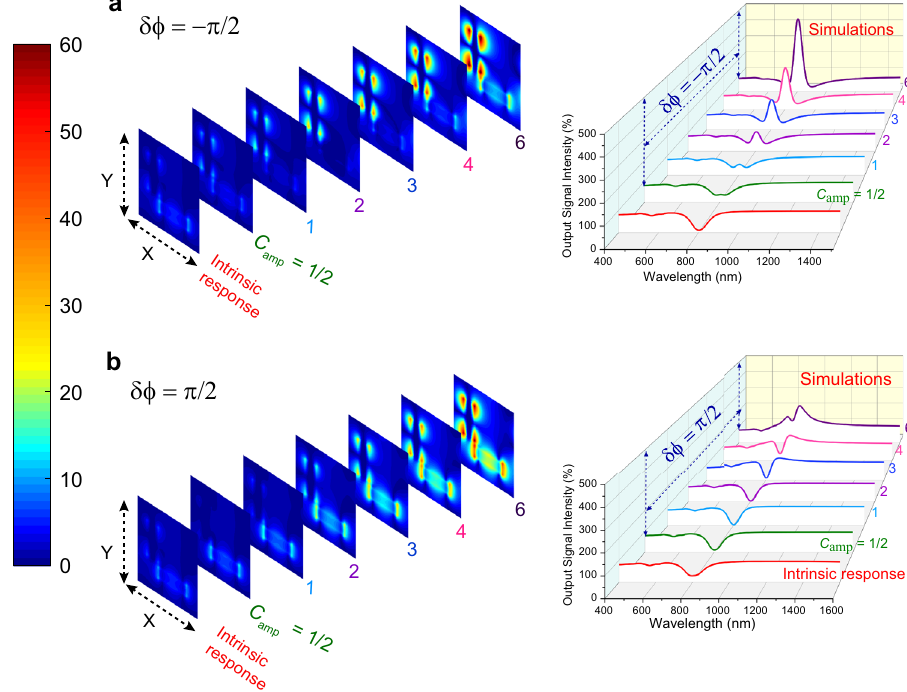
Fig. 4 Electric fi eld pro fi les and spectral response of output signal intensity. a , b x -polarized electric fi eld pro fi les and calculated output signal intensity curves as a function of control beam amplitude C amp with phase difference of δϕ = − π /2 and δϕ = π /2 in comparison to the intrinsic response,